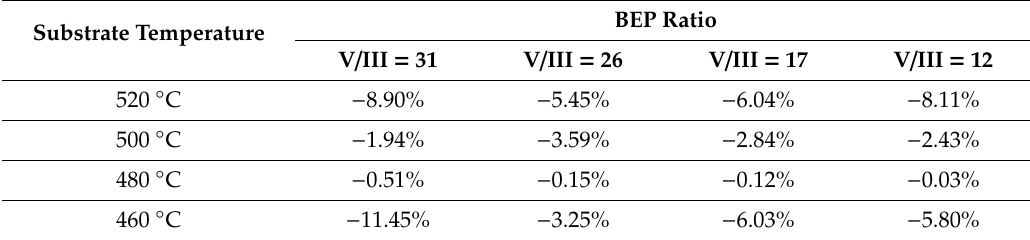
Table 2. The relative decrease of reflectance at probe wavelength of 633.1 nm at the end of the